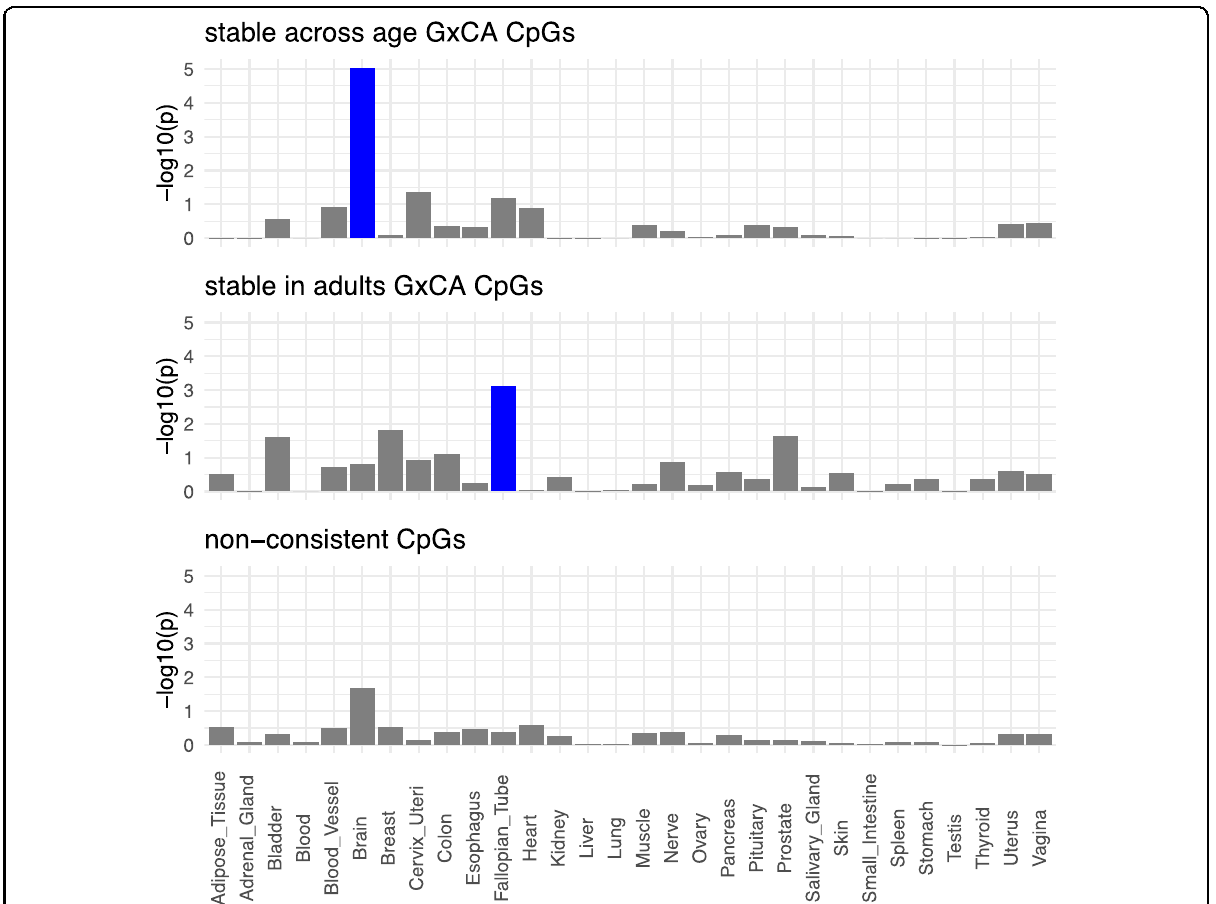
Fig. 4 Enrichment of stable across age G × CA, stable in adults G × CA and non-consistent CpGs for GTEx upregulated gene sets. The x -axis denotes the − log10( p value), and the y -axis the speci fi c tissue type. Signi fi cant enrichments (based on FDR correction of 0.05) are depicted in blue, and nonsigni fi cant in gray. For the group of nonconsistent CpGs, we randomly picked ten subsets of genes mapping to nonconsistent CpGs, equal in number to the genes mapping to stable across age G × CA CpGs. None of these subsets presented with signi fi cant adjusted p values for enrichment. In the plot, median p values across all subsets are